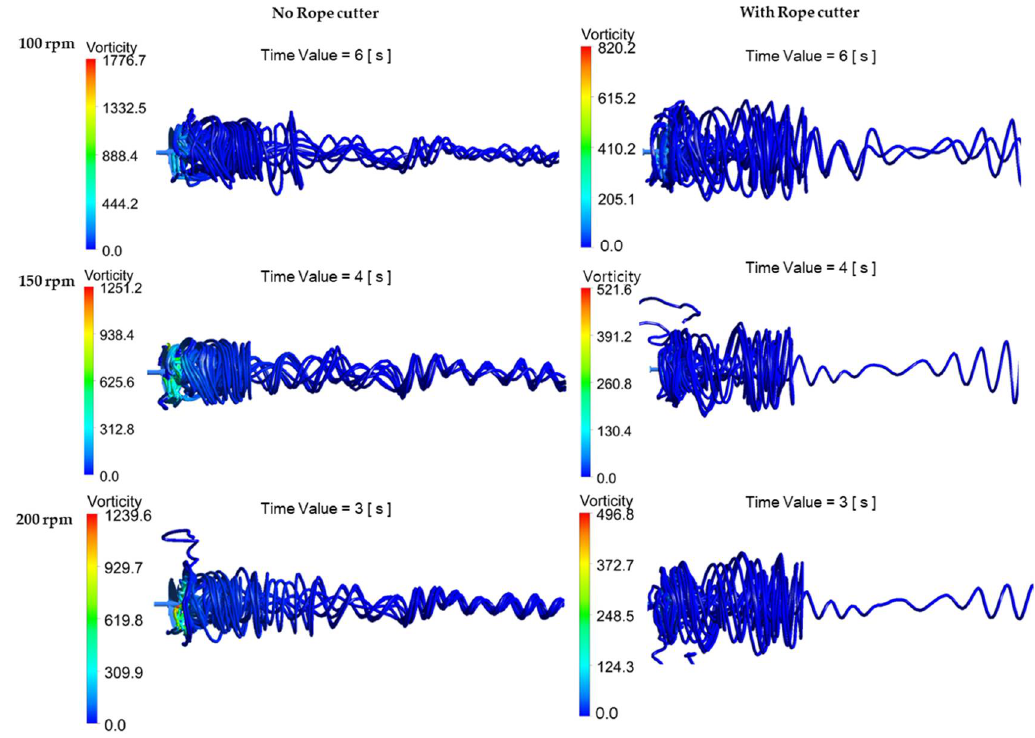
Figure 16. Effects of rope cutter on the vorticity in water flow behind the propeller.